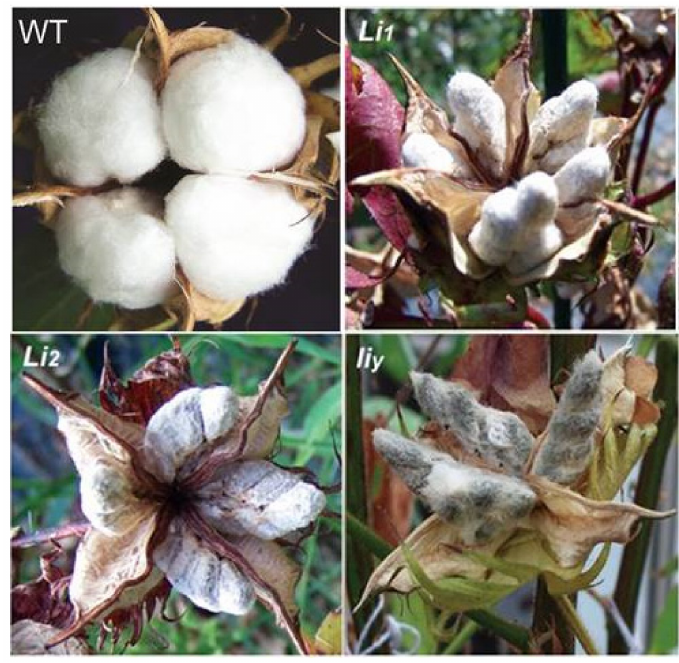
Figure 1. Fiber phenotypes of wild-type and three mutant